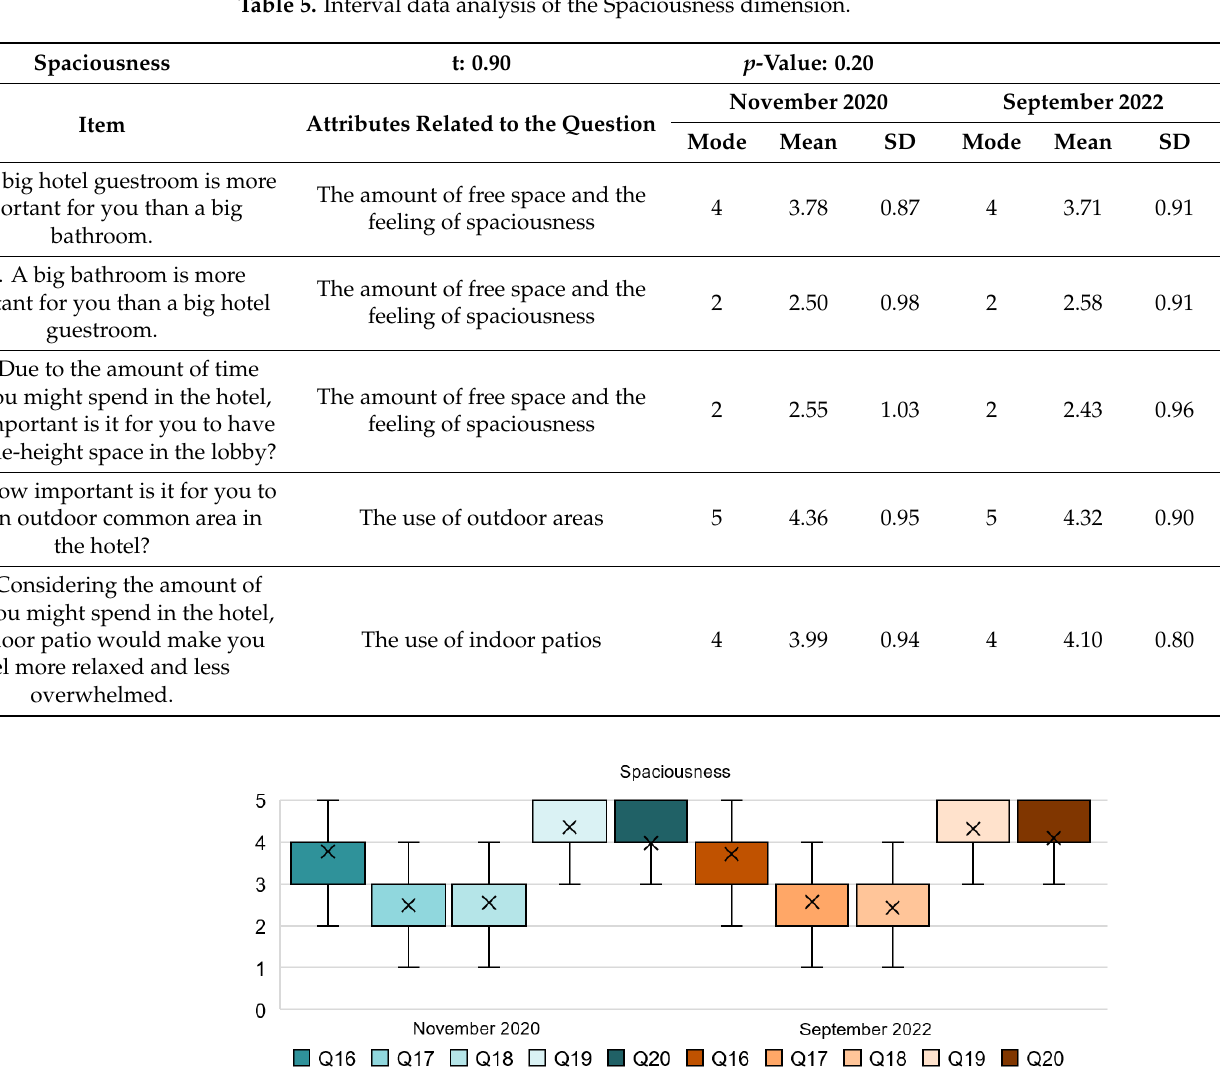
Figure 8. Spaciousness dimension chart. 4.5. Analysis of the Physiological Conditions dimension